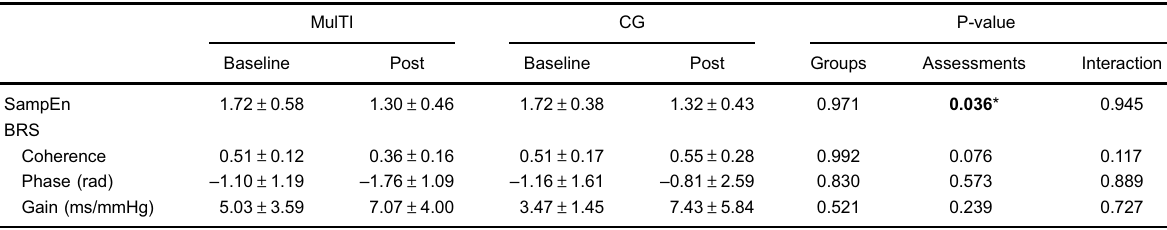
Table 2. SampEn and barore fl ex sensitivity in MulTI and CG groups in supine position. MulTI CG P-value Baseline Post Baseline Post Groups SampEn